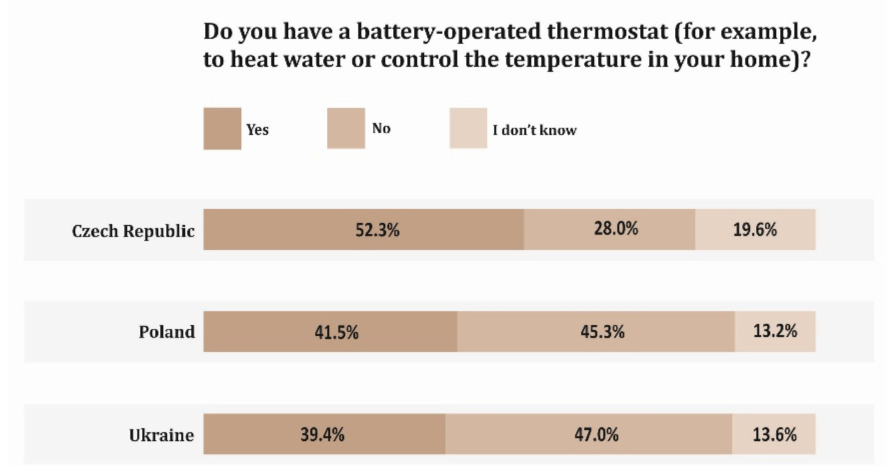
Figure 3. A thermostat to regulate the temperature of water in the household. Source: own study.